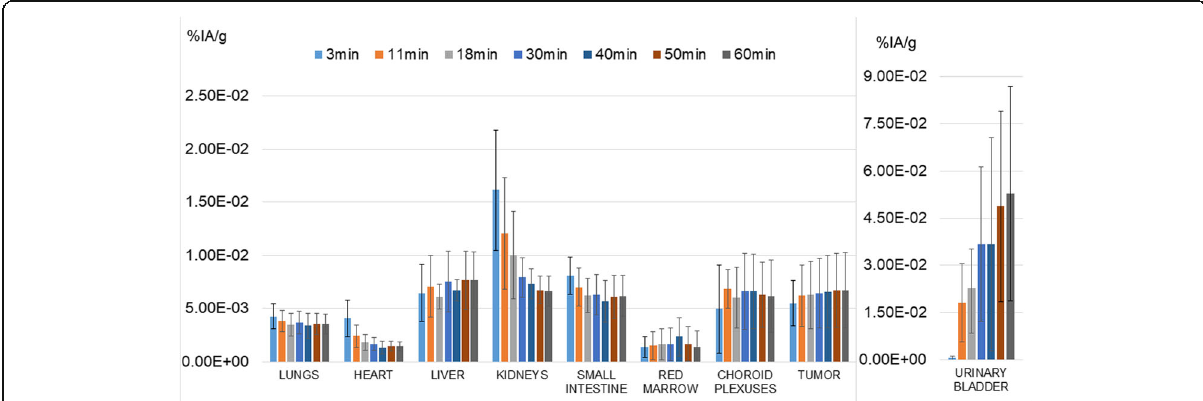
Fig. 3 Biological organ kinetic of 18 F-AzaFol corrected for 18 F physical decay. Color bars represent the average percent of injected activity per gram of tissue (%IA/g) ± 1SD, for each time point